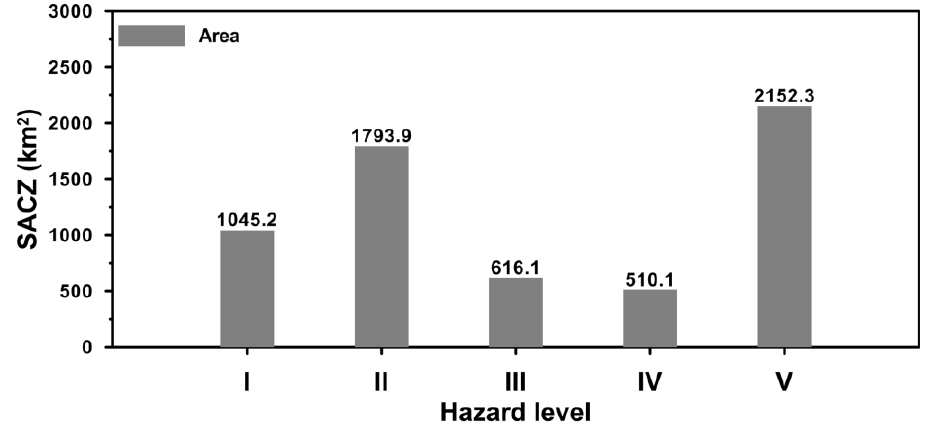
Figure 13. Areas of SACZs corresponding to each hazard level for the comprehensive storm wave hazard map.